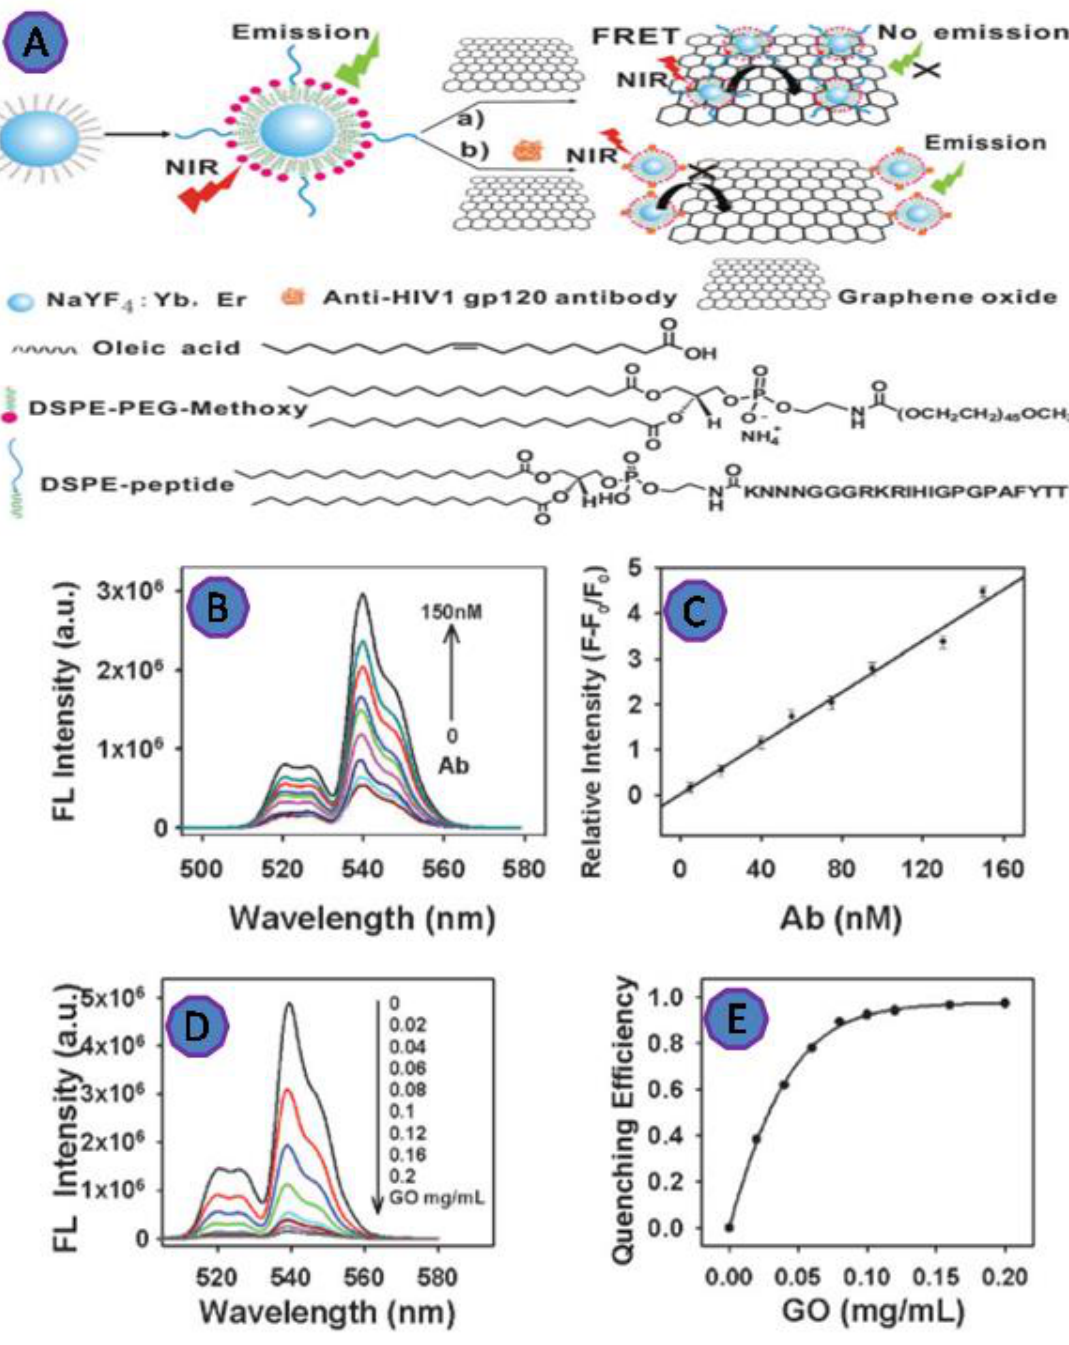
Figure 7. ( A ) Scheme of the upconversion FRET-based biosensor for detecting anti-HIV-1 gp120 antibody; ( B ) the upconversion fluorescence emission of the biosensor; ( C ) the calibration curve of the UCNPs showed a linear response with the various antibody concentrations in the range of 5–150 nM; ( D ) the fluorescence spectra of the peptide-functionalized UCNPs after incubation with varying concentrations of GO; ( E ) fluorescence quenching efficiency against GO concentration. Reprinted with permission from Ref. [72]. Copyright 2022, ROYAL SOCIETY OF CHEMISTRY.